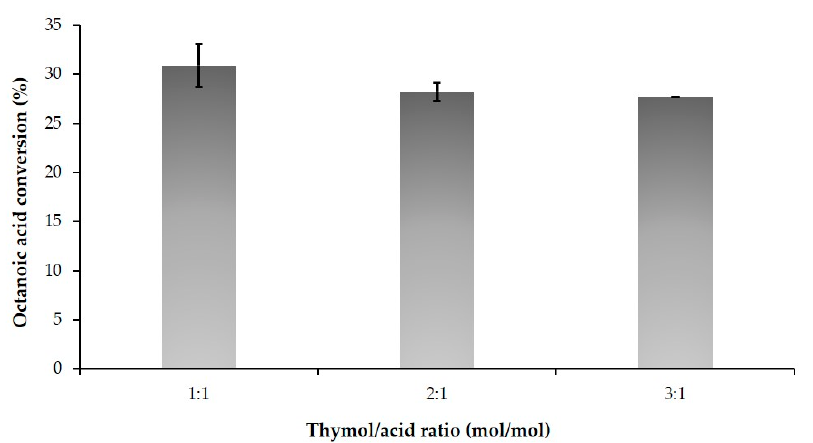
Figure 3. Change of the conversion of octanoic acid as a function of the molar ratio of substrates. Reaction conditions: 2 mmol of octanoic acid, 200 µ L of CALB solution (50.5 mg mL − 1 of protein), Reaction conditions: 2 mmol of octanoic acid, 200 µL of CALB solution (50.5 mg mL − 1 of protein), 50 50 ◦ C, 24 h, and magnetic stirring at 200 °C, 24 h, and magnetic stirring at 200 rpm.